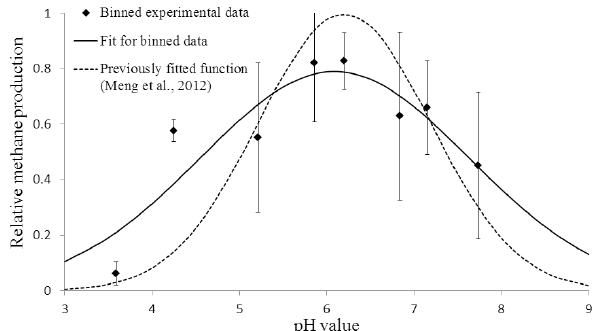
Figure B1. Empirical function of relative methane production dependence on pH. The function from Meng et al. (2012) is given for compar- ison. Whiskers denote ± 1SD for binned values of production, according to data presented in Meng et al. (2012).